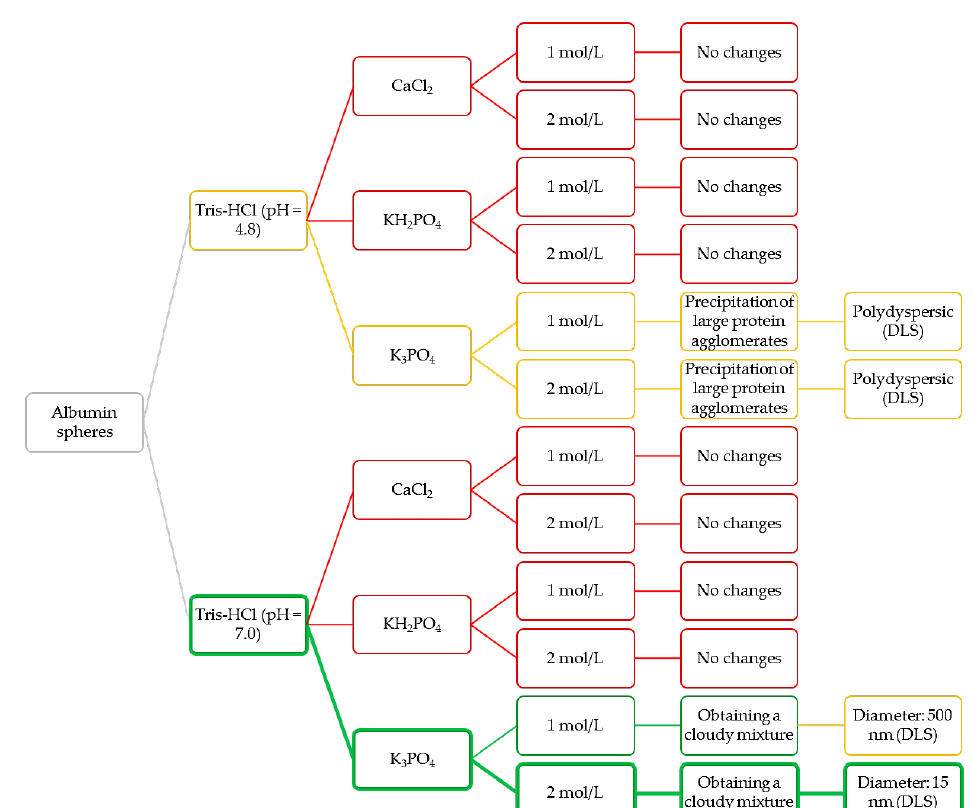
Figure 4. Design of the performed experiments aimed at selecting the most appropriate conditions for preparation of albumin nanoparticles.